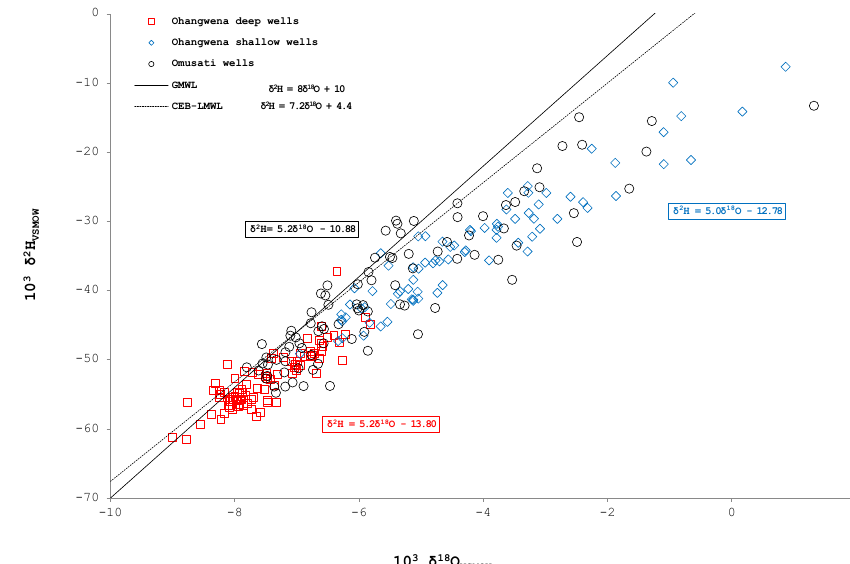
Figure 3. δ 2 H vs. δ 18 O plot of all collected samples including the global meteoric (GMWL) and local meteoric (LMWL) water lines.